Question: In a single sentence, describe what this figure presents.
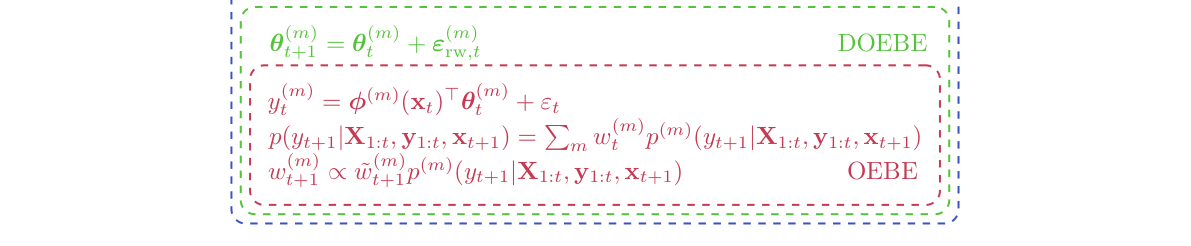
Answer: The hierarchy of the proposed models. All models have the same distribution for yt conditioned on θt, while DOEBE adds a random walk to parameters, and SDOEBE adds a random walk to BMA weights.